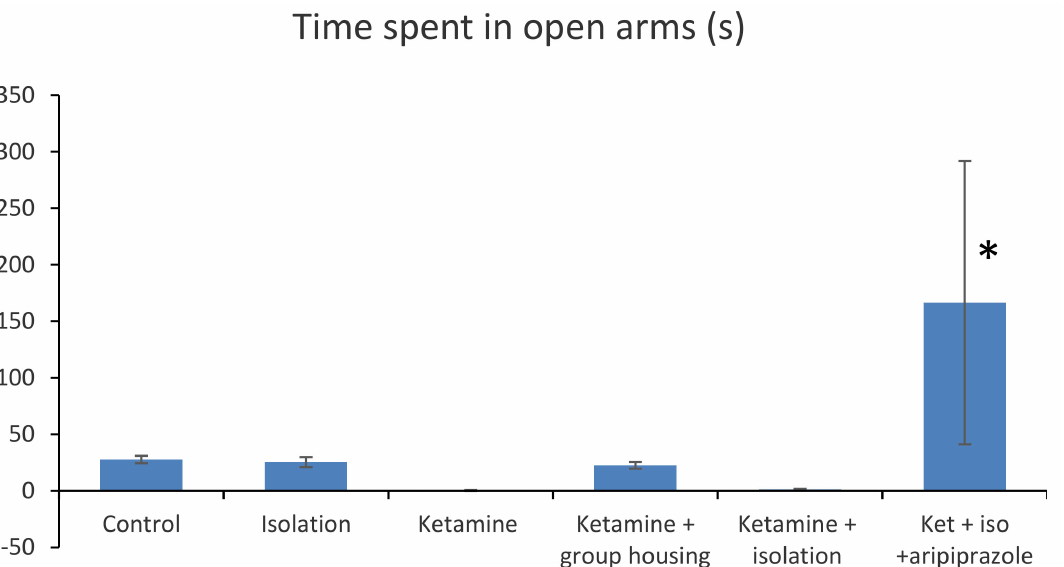
Figure 2. Behavioral results in the elevated plus maze of the six analyzed groups based on the time spent in open arms (s). The values are mean. * Significantly different when compared to control group ( p <